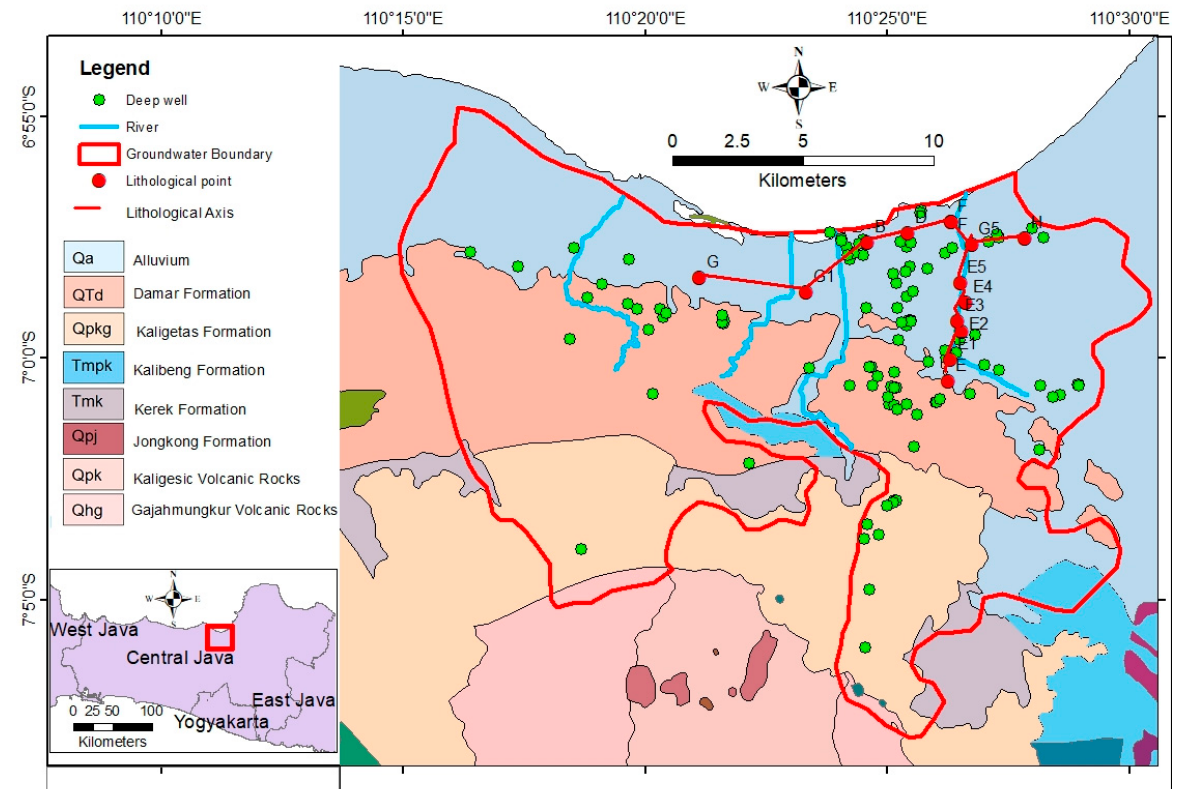
Figure 3. Geological map of Semarang City. Source of geological map: Thaden [35].